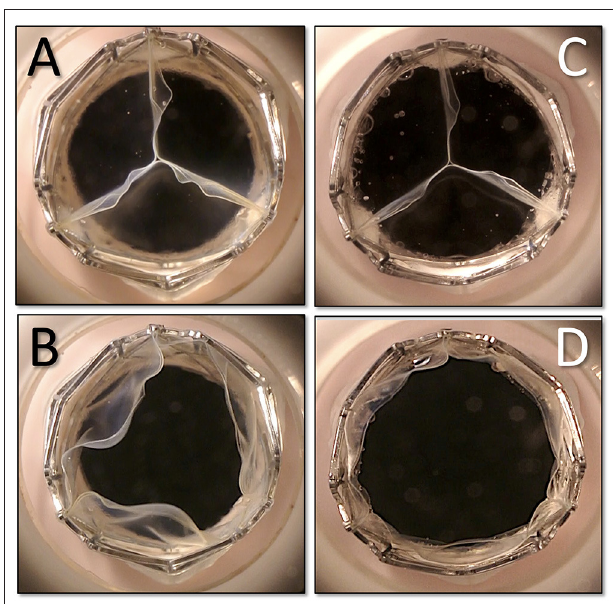
FIGURE 4 | Fine-tuning of the thickness of the polymer leaflets in the pulse duplicator. With twice the cusp thickness on the left side (A,B) end-diastolic